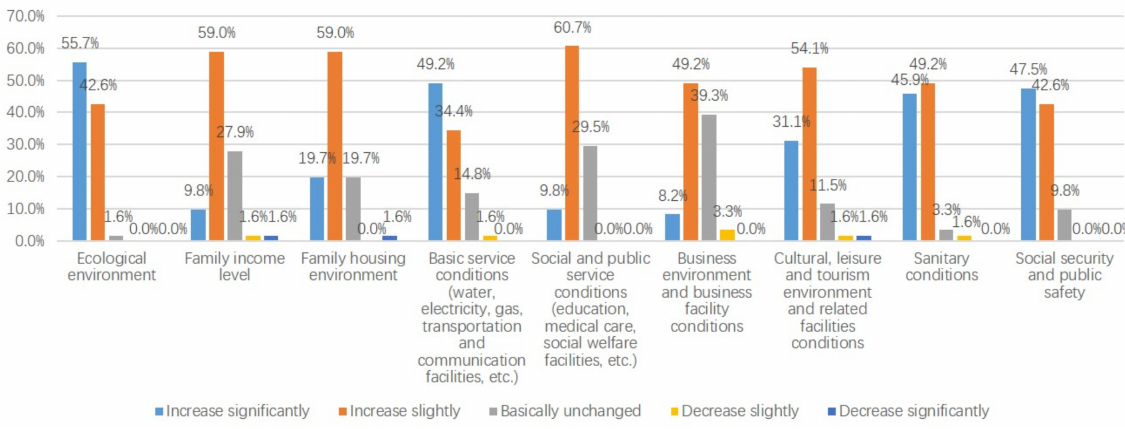
Figure 11. The influence of the CT practice on the living conditions of respondents (YDT) (source: authors).